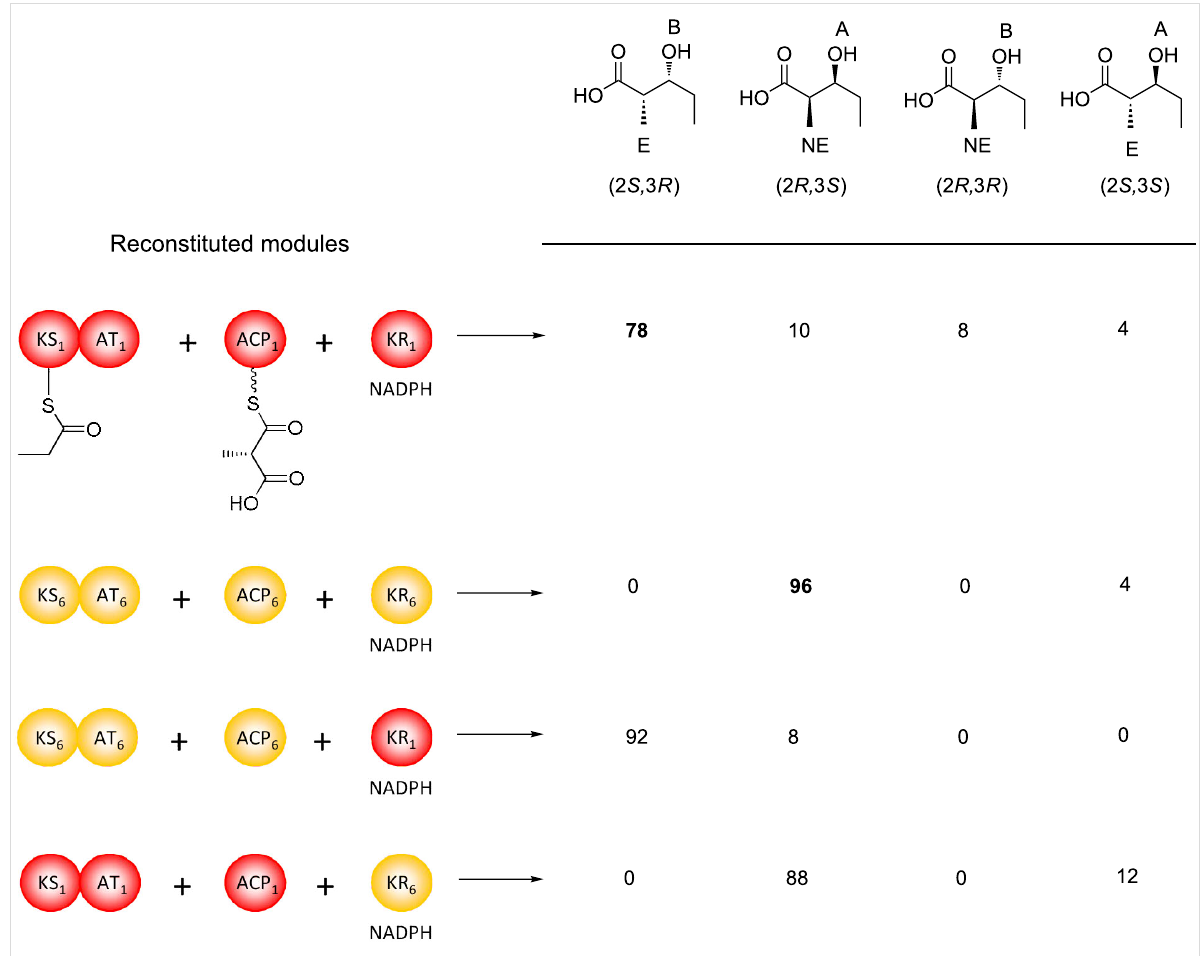
Figure 13: Assays in vitro which provided the first direct evidence that KR domains act as epimerases [77]. Biosynthesis in these experiments was carried out by reconstituted modules comprising KS-AT didomains and isolated KR and ACP domains. The KS was charged with the propionate starter unit from propionyl-SNAC, and the ACP with extender unit by the AT domain using (2 S )-methylmalonyl-CoA. The product diketides were hydrolyzed from the ACP domains and their stereochemistries were determined by chiral GC–MS. Reconstituted DEBS modules 1 and 6 (red and yellow, respectively) gave predominantly the expected products (epimerized C-2 methyl and B-type alcohol stereochemistry for module 1; non- epimerized C-2 methyl and A-type alcohol stereochemistry for module 6 (indicated in bold)), while exchanging only the KR domain caused the recon- stituted modules to produce the product characteristic of the introduced KR (for example (line 3), KR 1 in place of KR 6 resulted in the native product of module 1). Thus, the KRs were shown to control the stereochemistry at both the C-2 and C-3 positions of the chain extension